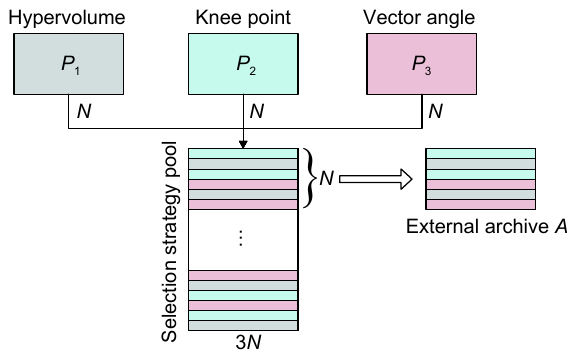
Fig. 1 Main procedure of elite individual